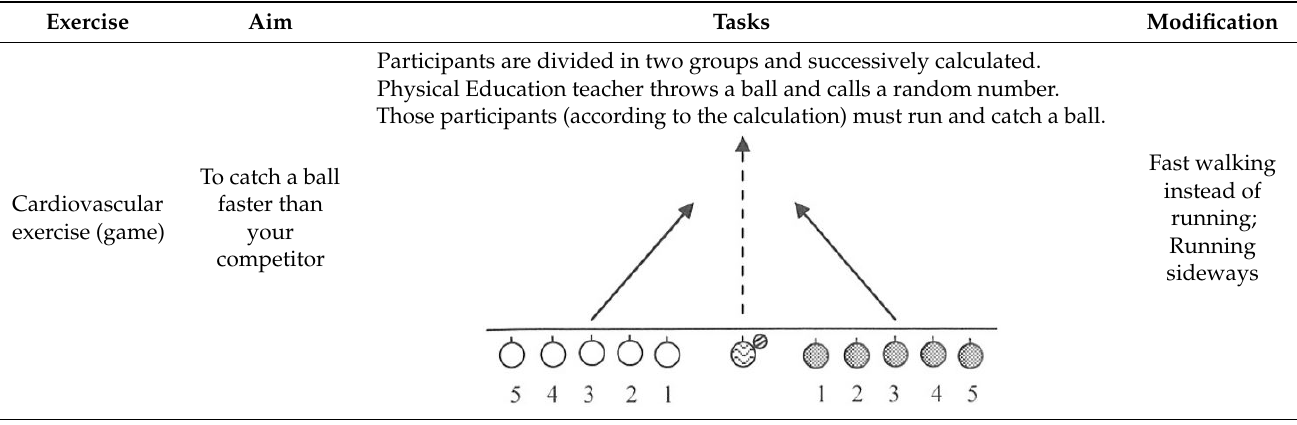
Table 2. Example of intervention exercises.